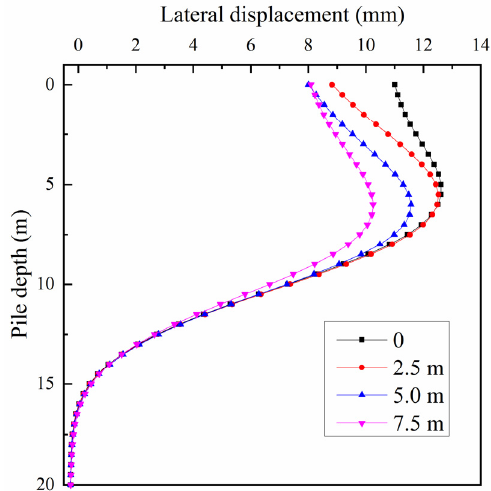
Figure 18. Influence of the pre-drilling depths of the new pile on the lateral displacement of the used pile.